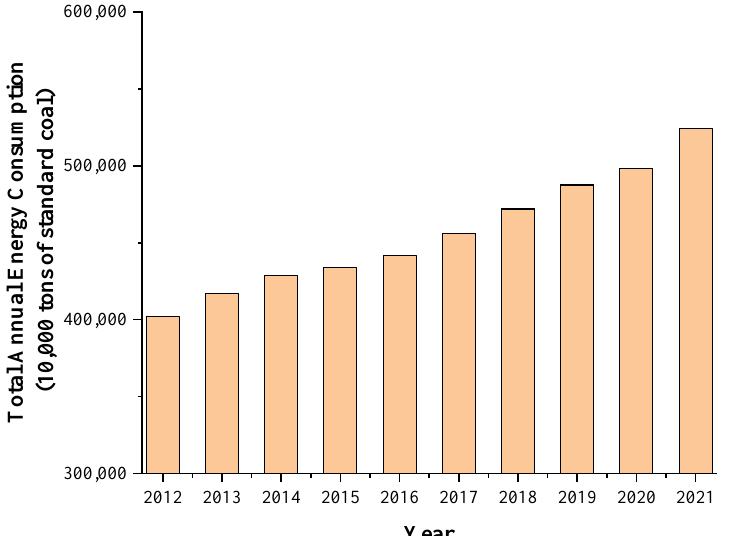
Figure 1. China’s energy consumption over the Figure 1. China ’ s energy consumption over the years.